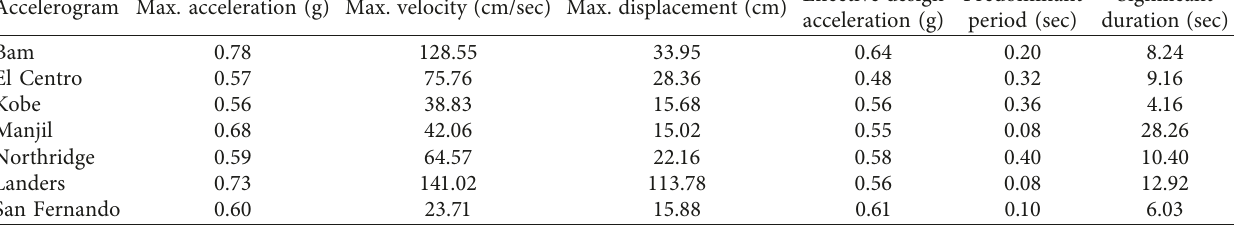
Table 4: Scaled earthquakes’ specifications.